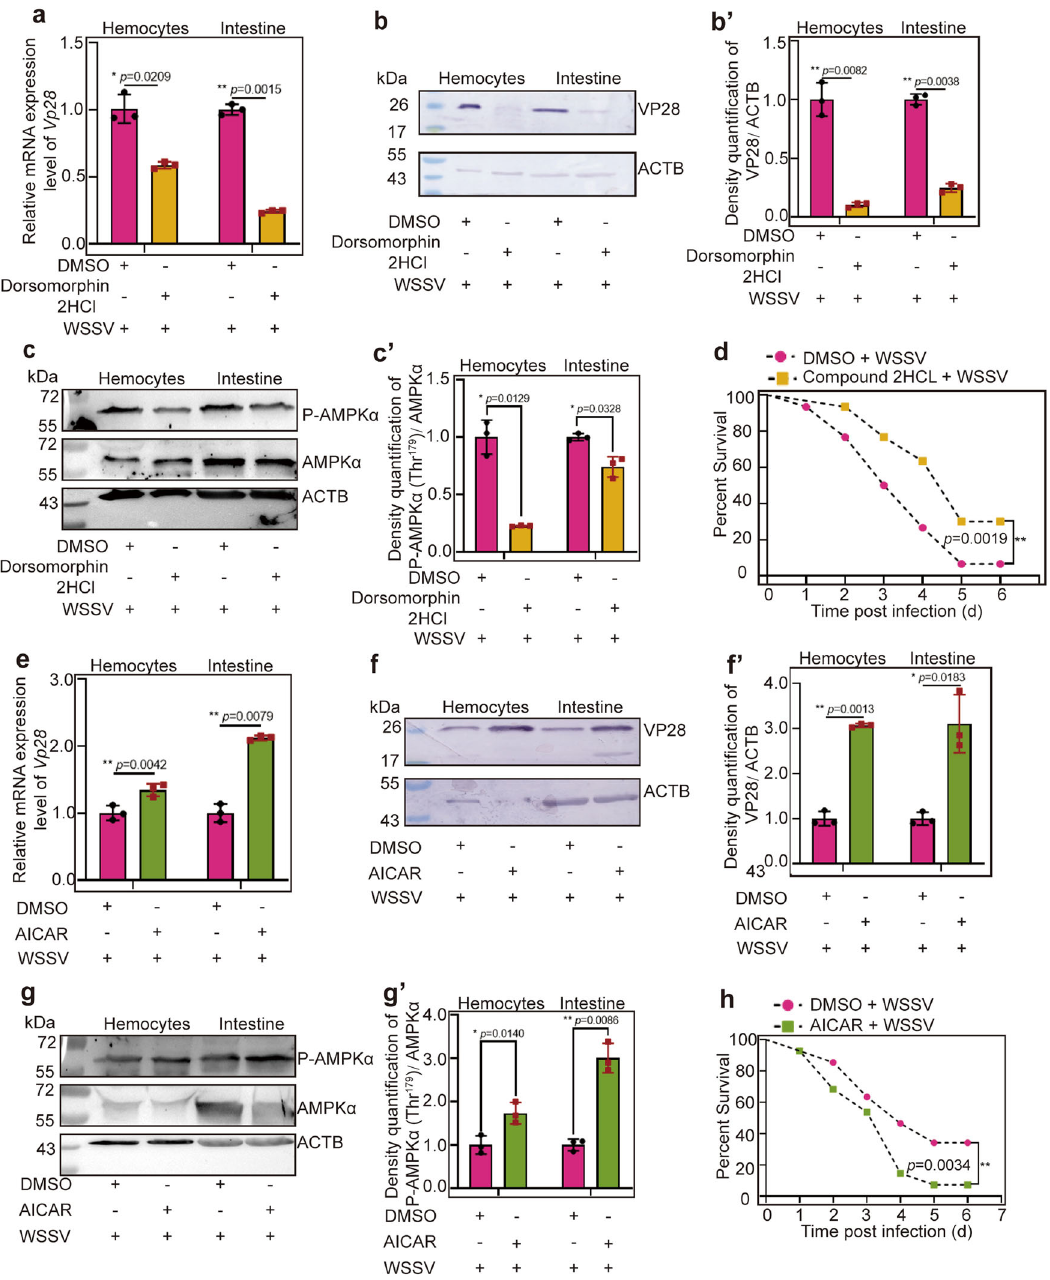
Fig. 3 WSSV replication was decreased in inhibitor-injection shrimp and increased in activator-injection shrimp challenged by WSSV. a – c VP28 expression at the mRNA ( a ) and protein ( b ) levels and AMPK phosphorylation ( c ) in hemocytes and intestine of Dorsomorphin 2HCL-injection shrimp following WSSV infection, DMSO was used as control. b ′ , c ′ The statistical analysis of panel b or c based on three replicates. d Survival rate of the Compound 2HCL-injected shrimp challenged by WSSV ( n = 30) and the control group injected with DMSO ( n = 30). Signi fi cant differences were analyzed using the log-rank test in GraphPad Prism 8.0 software. e – g VP28 expression at the mRNA ( e ) and protein ( f ) levels and AMPK phosphorylation ( g ) in hemocytes and intestine of AICAR-injected shrimp following WSSV infection, DMSO was used as a control. f ′ , g ′ is the statistical analysis of panel f and g based on three replicates. h Survival rate of the AICAR-injected shrimp challenged by WSSV ( n = 40) and the control group injected with DMSO ( n = 40). Signi fi cant differences were analyzed using the log-rank test in GraphPad Prism 8.0 software. All results are shown as means ± SD for experiments performed at least three times; the data were analyzed statistically using Student ’ s t test. * P < 0.05; ** P < 0.01; *** P <